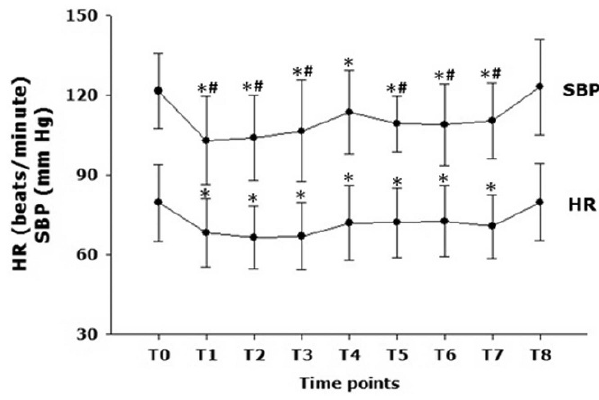
Figure 1 - Heart rate and systolic blood pressure (mean ¡ standard deviation) at baseline and at the different time points in the study. (T0) before anesthesia induction; (T1) after induction and before tracheal intubation; (T2) 5 minutes after tracheal intubation; (T3) immediately after abdominal insuffla- tion; (T4-T6) 15, 30, and 45 minutes after abdominal insufflation; (T7-T8) immediately after and 30 minutes after abdominal deflation. * p , 0.05 versus baseline values.